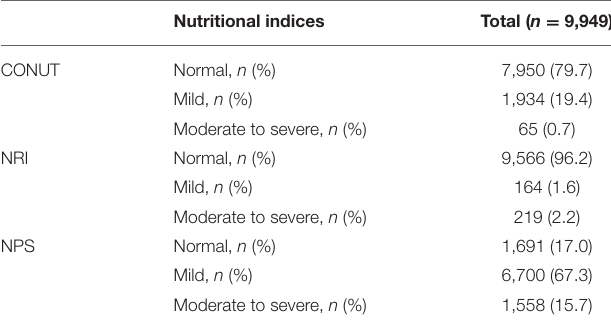
tools. Nutritional